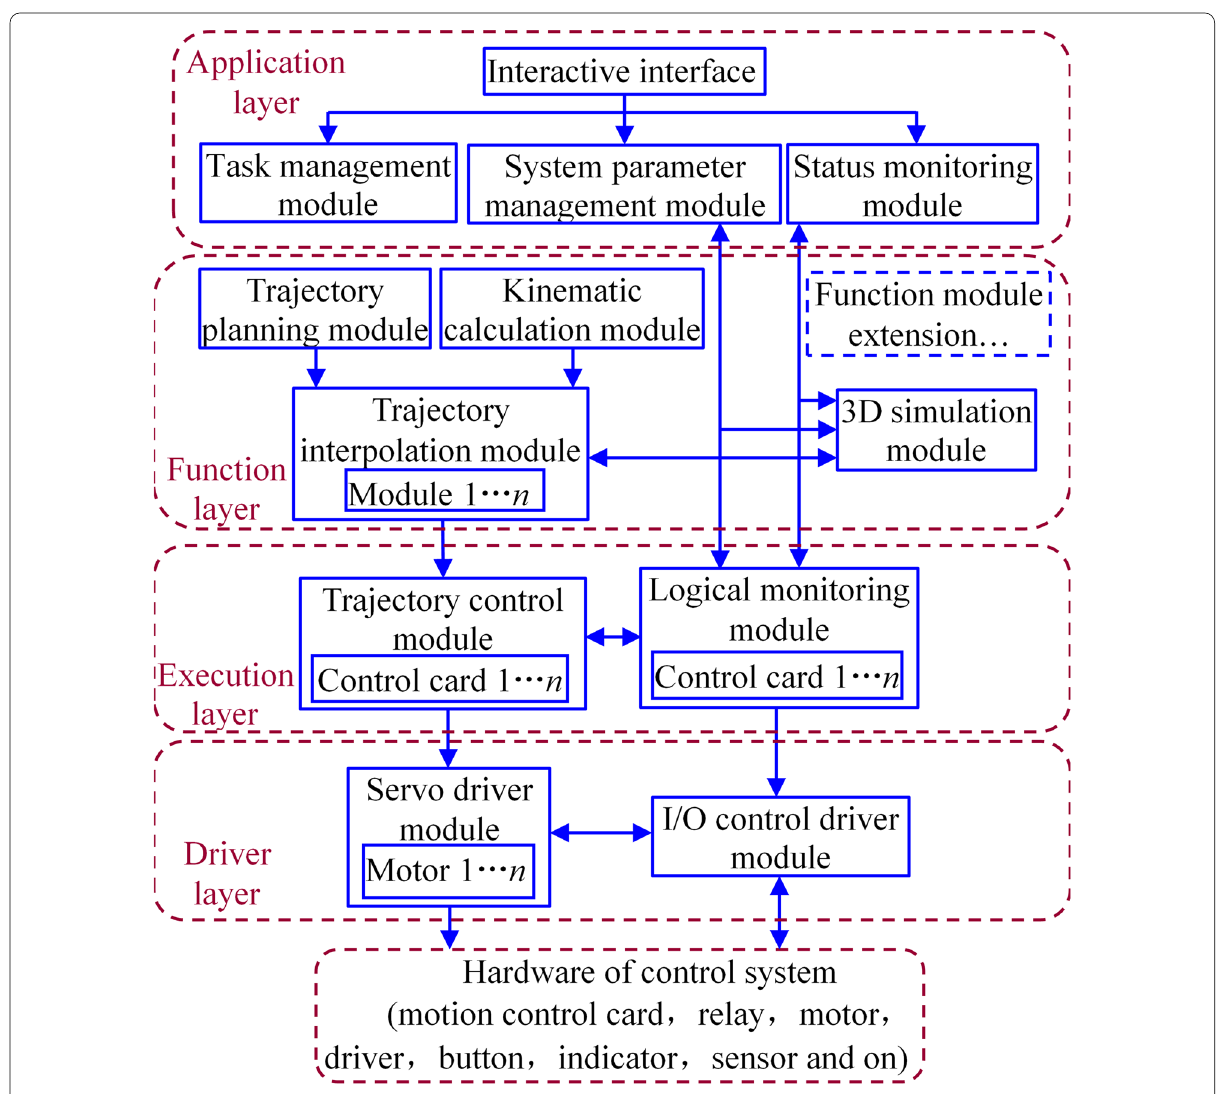
Figure 15 Software of the control system of the